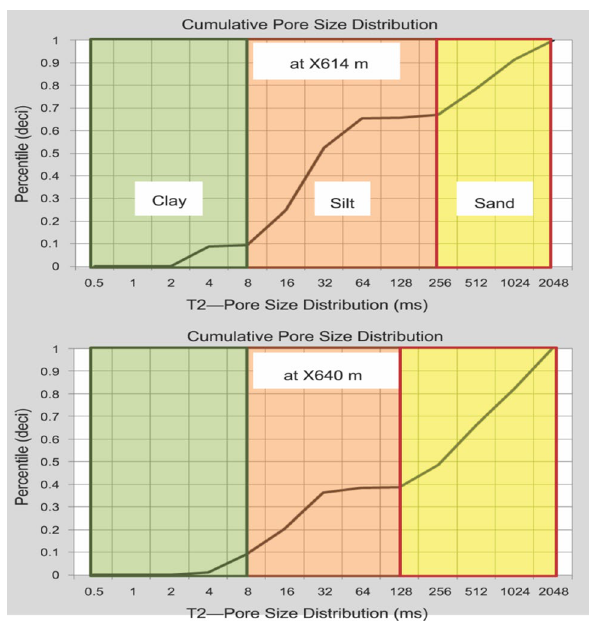
Fig. 6 Cumulative T 2 pore size distribution (percentile)